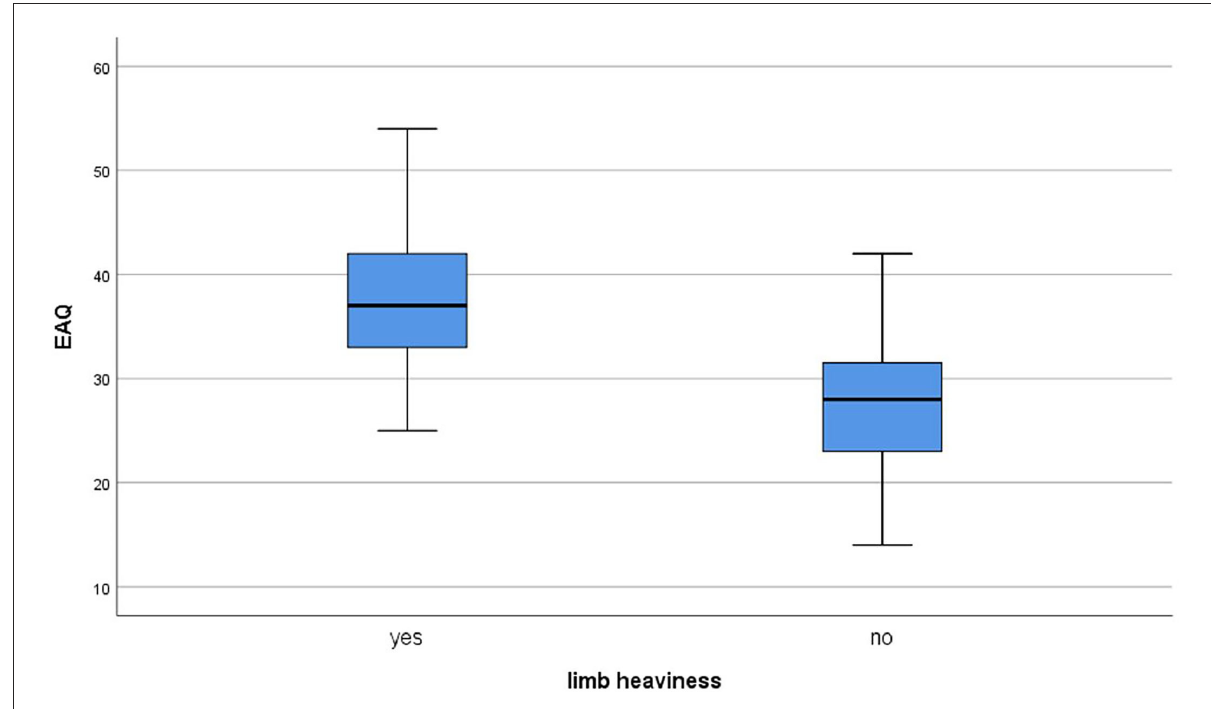
FIGURE2 The box of the relationship between perceived limb heaviness and rehabilitation